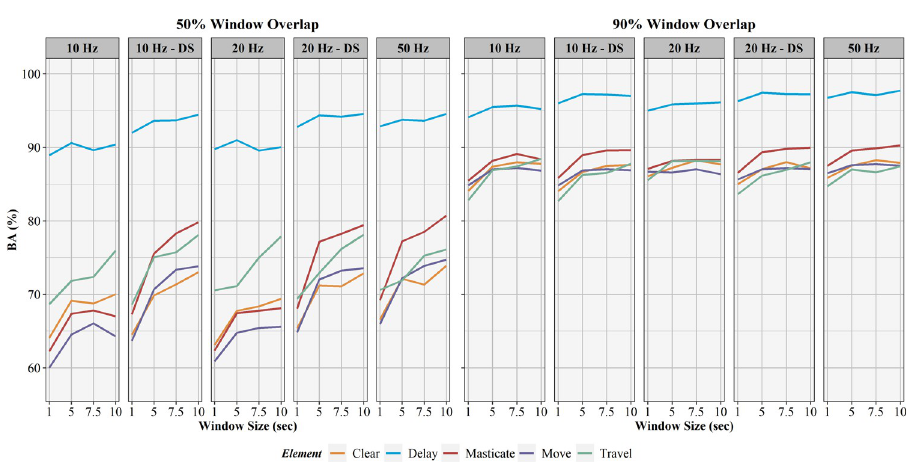
Fig 10. Balanced accuracy results for activity recognition models. Comparison of activity recognition model balanced accuracy percentages for 50% and 90% sliding window overlaps across the four sliding window lengths (1, 5, 7.5, 10 seconds) for each work element (clear, delay, masticate, move, travel).